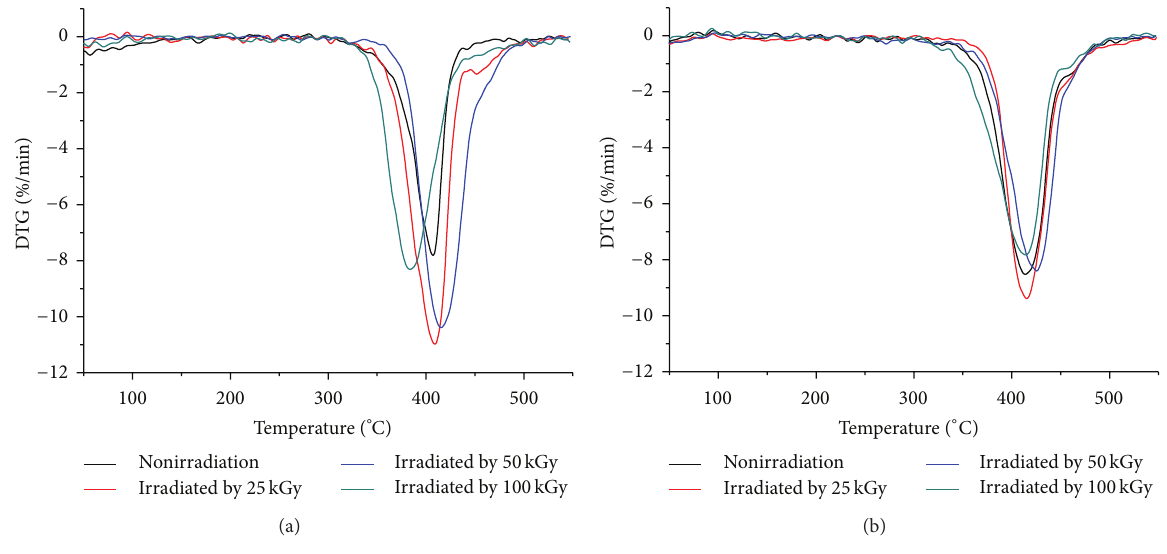
Figure 3: The effect of irradiation dose on DTG curves of 40 wt% (a) and 50wt% (b) nHA/PA66 composite scaffolds.